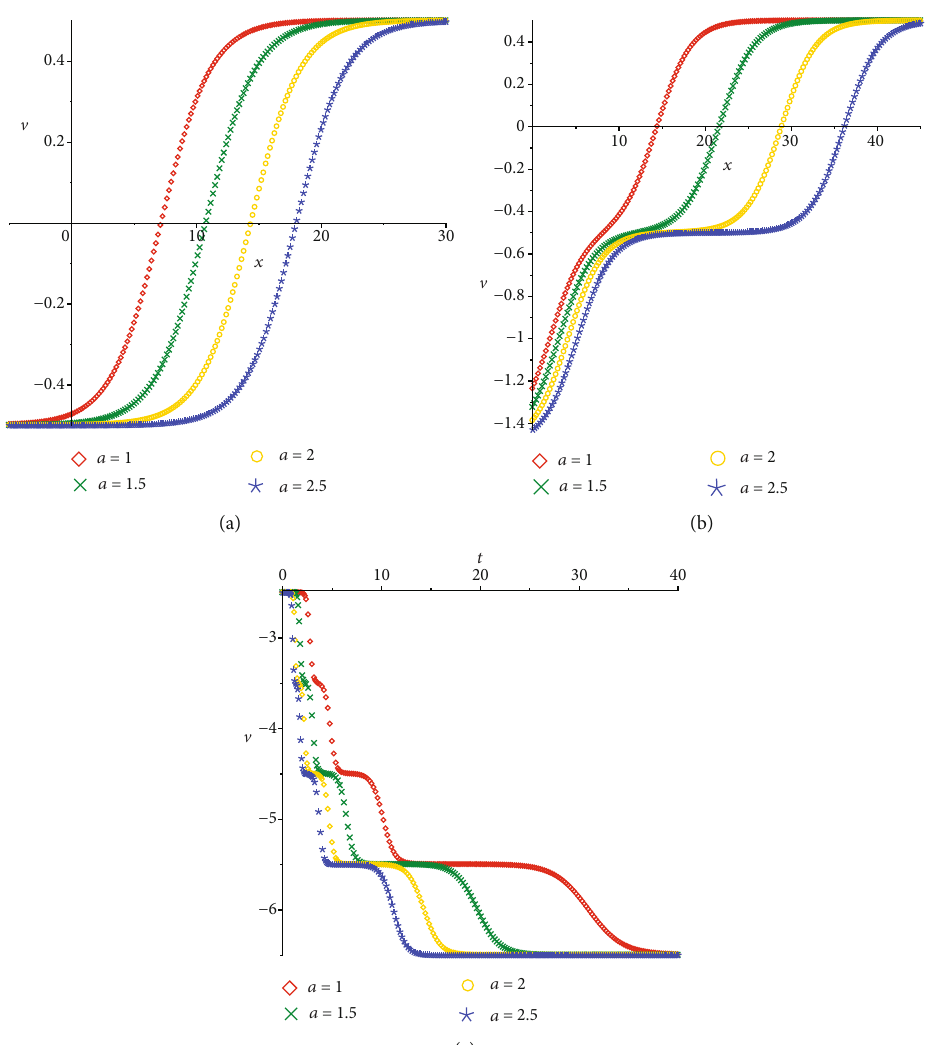
= 0 : 5 at t = 40 . (b) Two shock waves for δ = 0 : 9, l 1 = 0 : 5, l = 1, l = 1 : 5, l = 2, l = 2 : 5 at x = 40 1 2 3 4 5